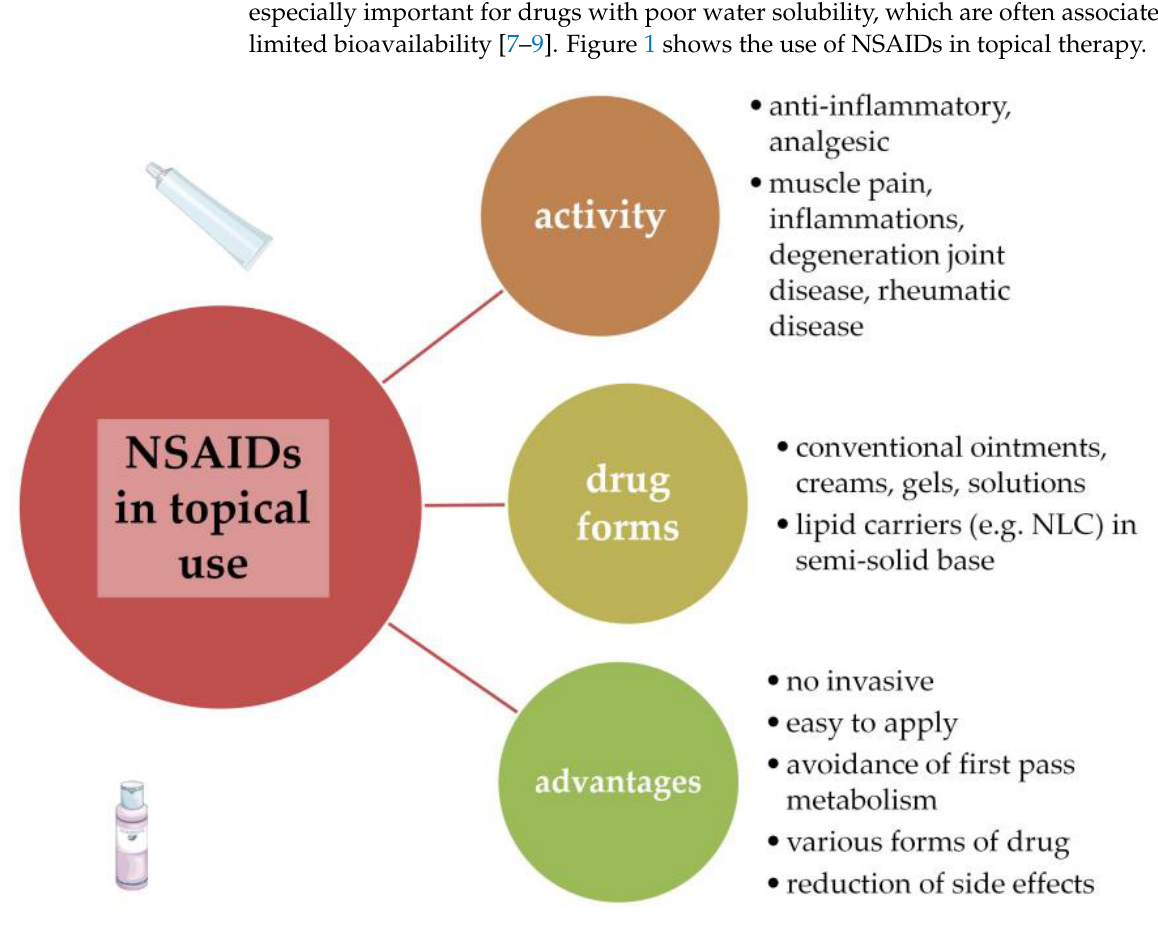
Figure 1. NSAIDs in topical therapy [9,10].